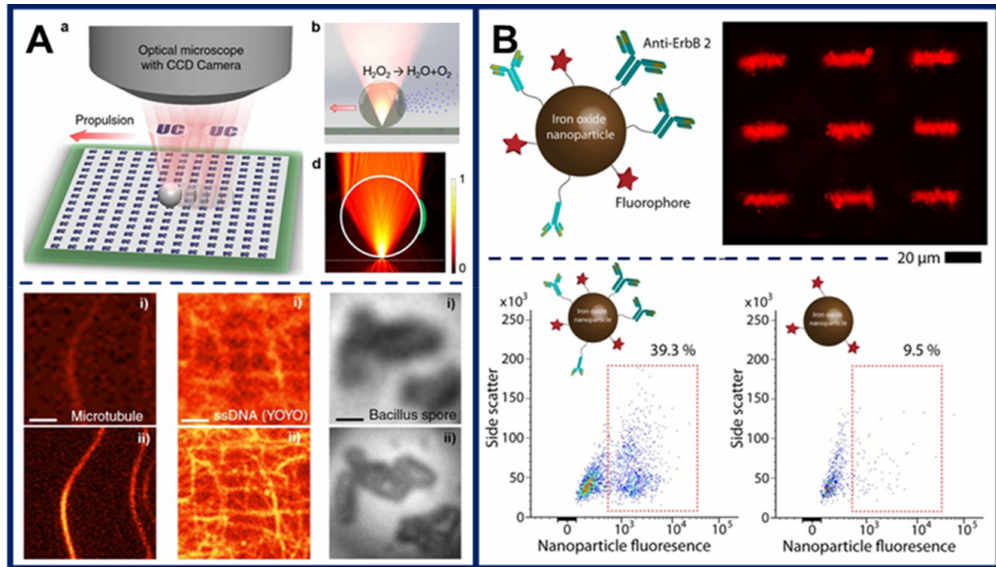
Figure 8. ( A ) Microswimmer-enabled optical nanoscopy. (Top) Schematics showing the operating principle for microswimmer-enhanced imaging. (Bottom) Imaging of fluorescent and biological samples with and without microswimmer-enabled optical nanoscopy. The images acquired with the aid of microswimmers have significantly better resolution. Figure reproduced from [115], © 2016 American Chemical Society. ( B ) Targeted cell labeling using magnetic nanoparticles released from collapsed microswimmers. (Top) Design of superparamagnetic iron oxide nanoparticles functionalized with a fluorophore and an antibody for targeted labeling of breast cancer cells and epifluorescence image of microswimmers embedded with the nanoparticles. (Bottom) Labeling of the breast cancer cells shows much higher e ffi ciency for nanoparticles modified with the antibody. Figure reproduced from